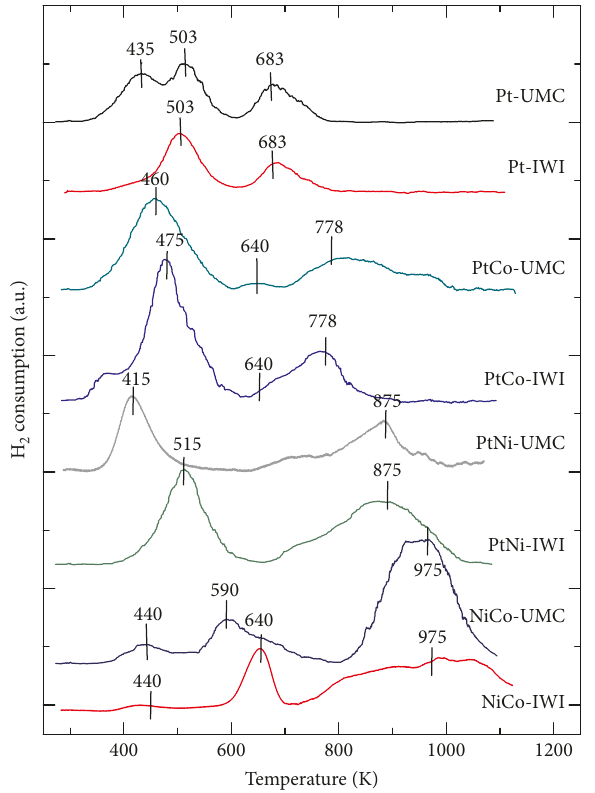
Figure 2: TPR traces of the tested